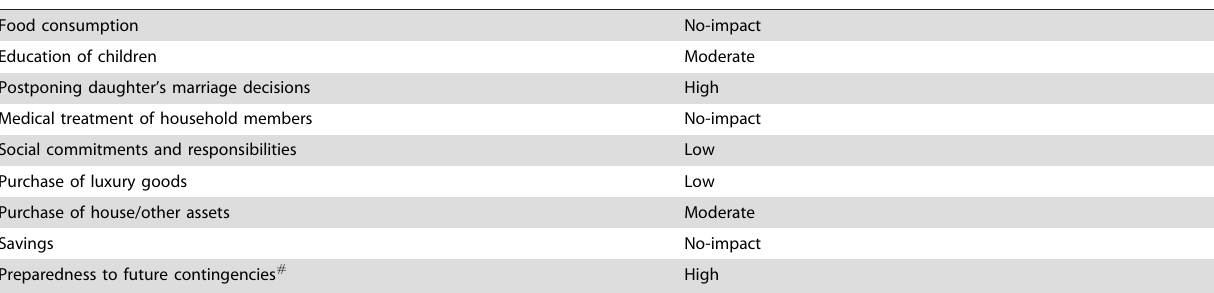
Domains of Welfare Loss/Sacrifice/Surrender of